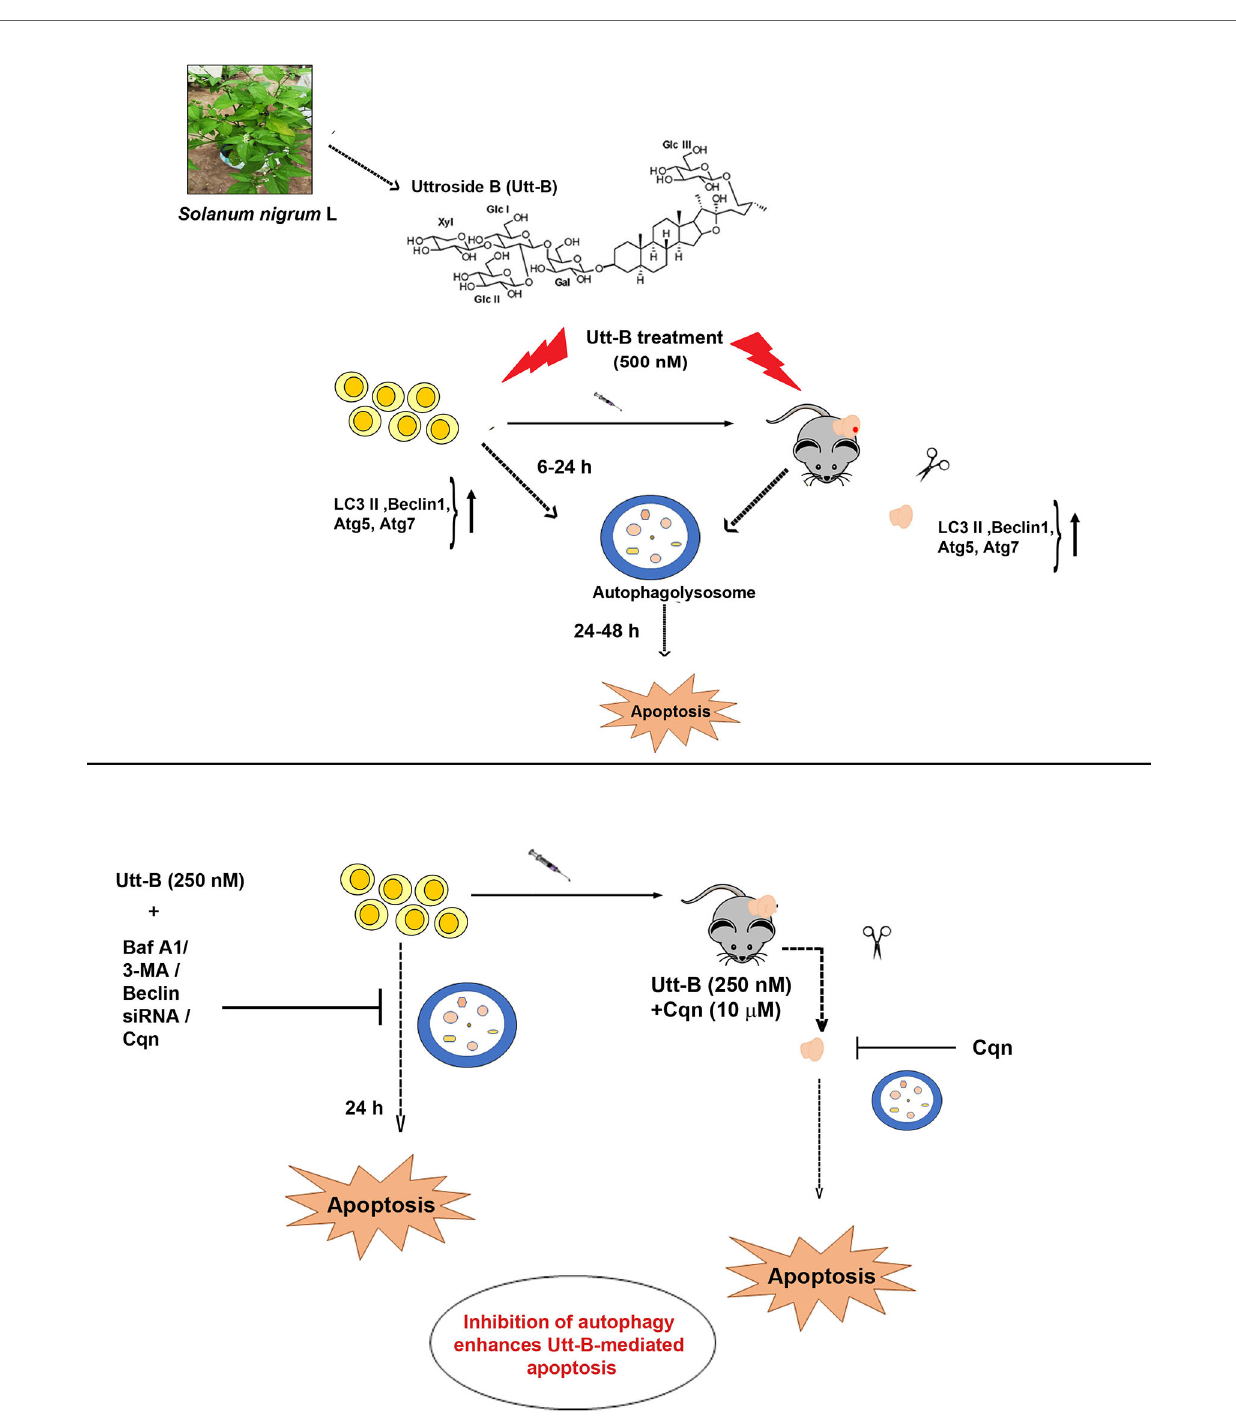
FIGURE 7 | Inhibition of Utt-B-induced autophagy improves the therapeutic ef fi cacy of Utt-B against HCC. Utt-B, a furostanol glycoside, isolated from the methanolic extract of Solanum nigrum L, is found to be an inducer of autophagy as evidenced by the up-regulation of autophagy markers such as LC3 II, Beclin 1, atg5, and atg7, both in vitro and in vivo . At in vitro conditions, autophagy peaks from 6-24h, followed by apoptosis. Inhibition of Utt-B induced autophagy, by pharmacological autophagy inhibitors such as Baf A1, 3-MA, Cqn, and biological inhibitor, Beclin siRNA enhances Utt-B mediated apoptosis, in vitro . Inhibition of Utt-B-induced autophagy by sub-toxic concentrations of Cqn enhances the chemotherapeutic potential of Utt-B, in vivo